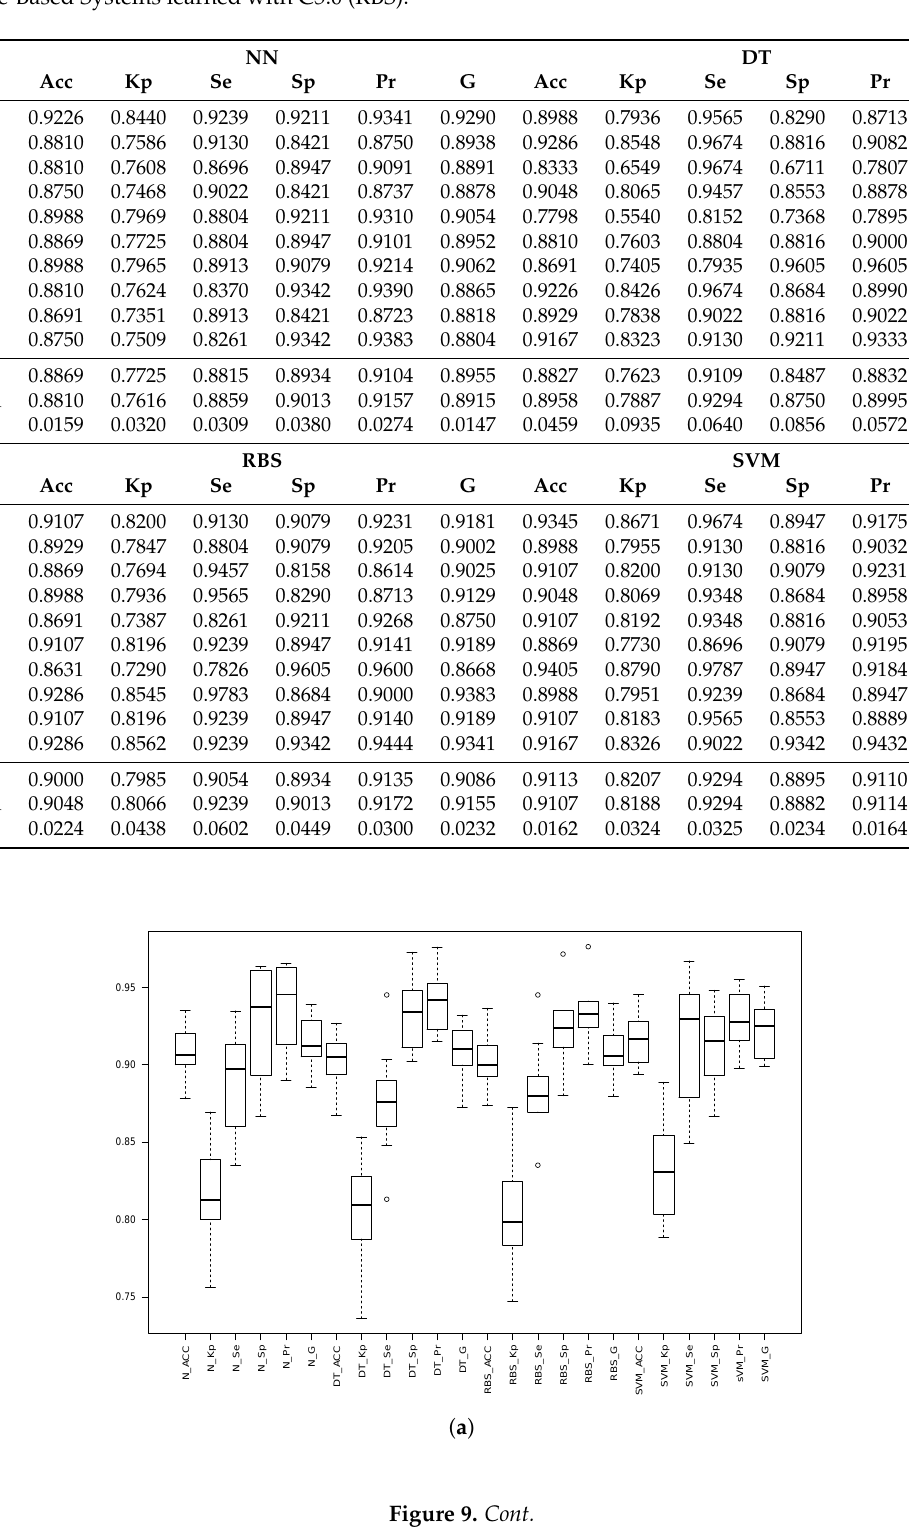
Table 10. Results obtained from the 5 × 2 cv when the threshold is set to 3.09290 × g : the different statistics are the Accuracy (Acc), Kappa factor (Kp), Sensitivity (Se), Specificity (Sp), Precision (Pr) and the Geometric mean (G), all of them computed using Equations (1) to (8). The three different models are feed forward NN, Support Vector Machines (SVM), Decision Trees learned with C5.0 (DT) and Rule-Based Systems learned with C5.0 (RBS).